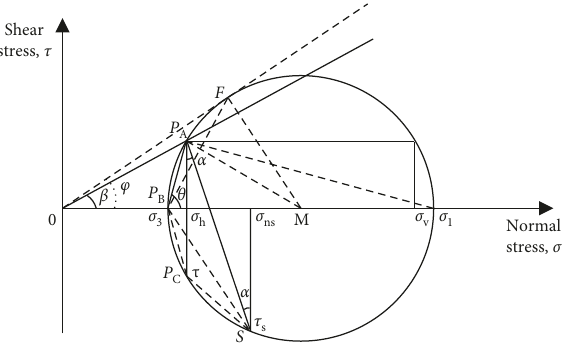
Figure 3: Mobilization of shear stress in the Mohr